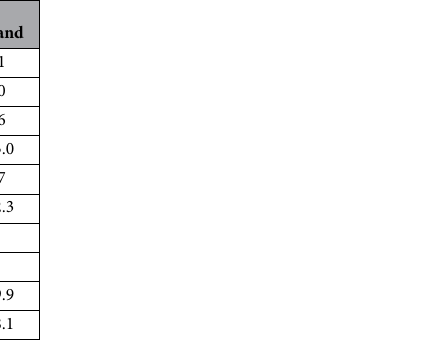
Table 2. Topsoil SOC data, 5–95 percentiles of %C.